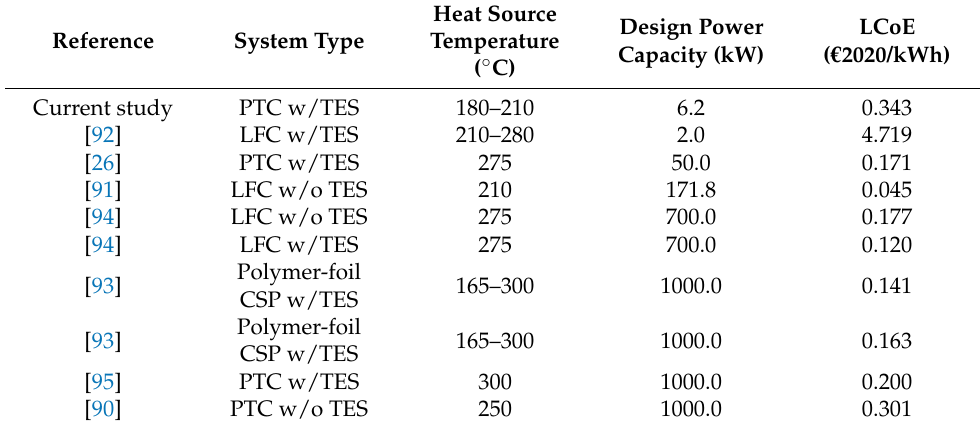
Table 13. Comparison summary between present work and related